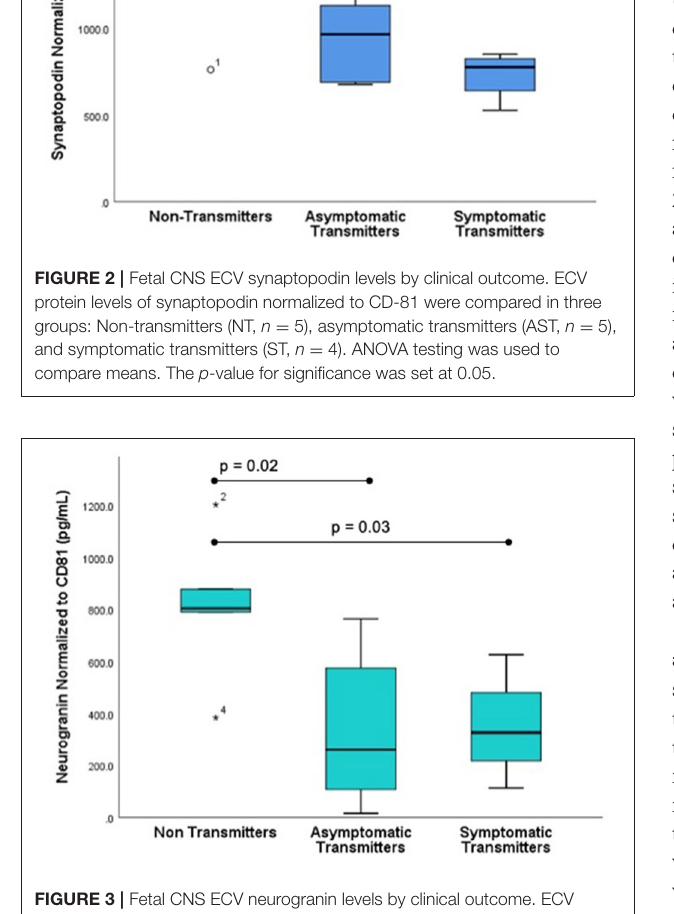
suggesting a possible role for multiple markers to improved diagnostic